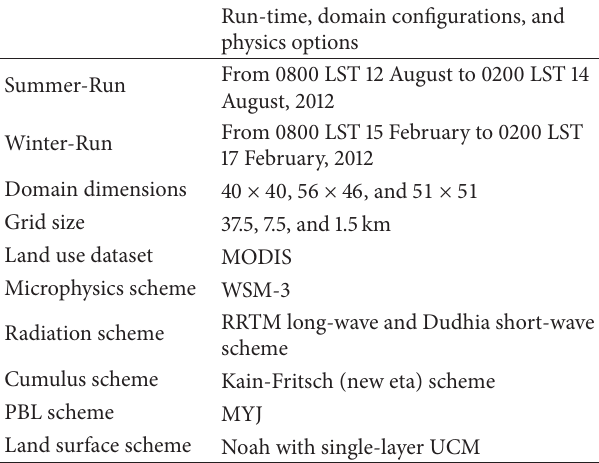
Table1:Run-time,domainconfigurations,andphysicsoptionsused in the WRF